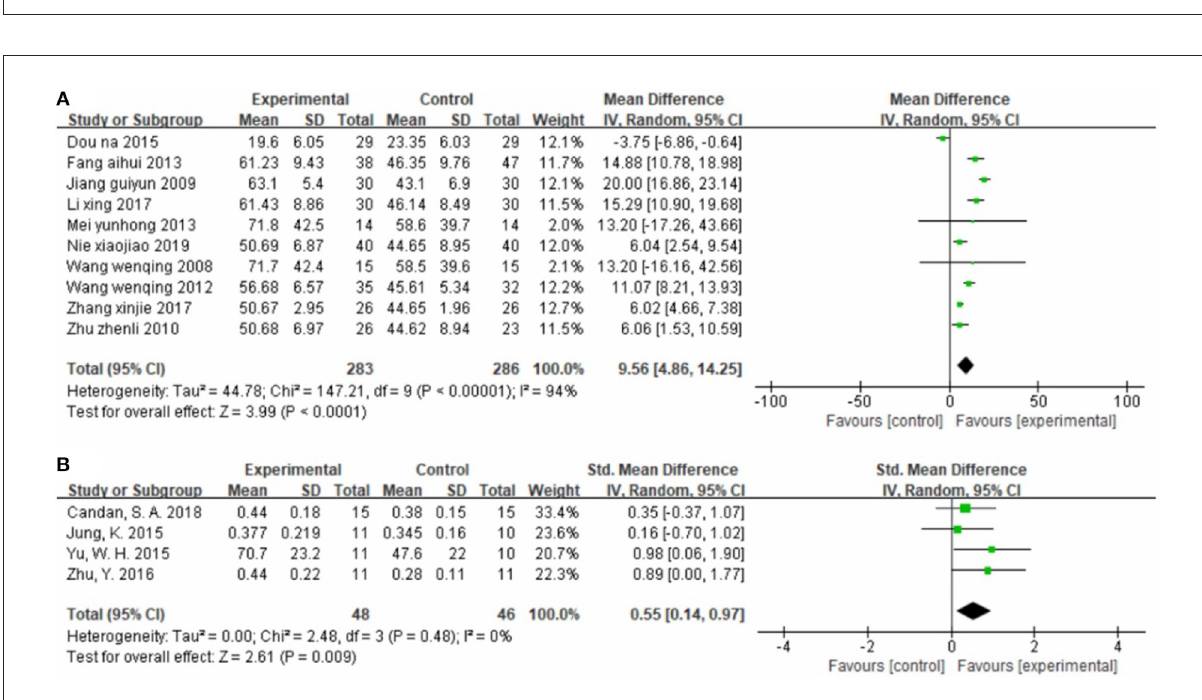
FIGURE4 CIMT vs. conventional physiotherapy on the 10-meter walk test (A) and gait speed (B)